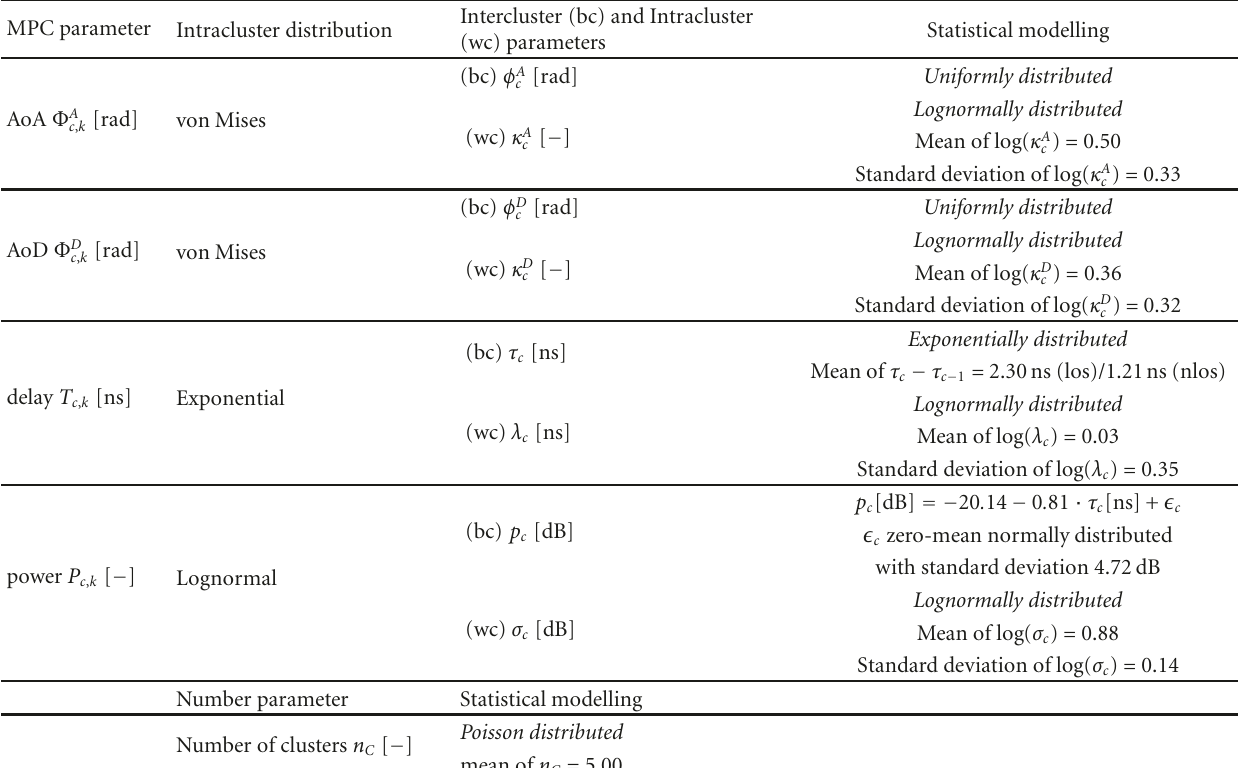
Table 2: Summary of statistical modelling of MPC parameters with